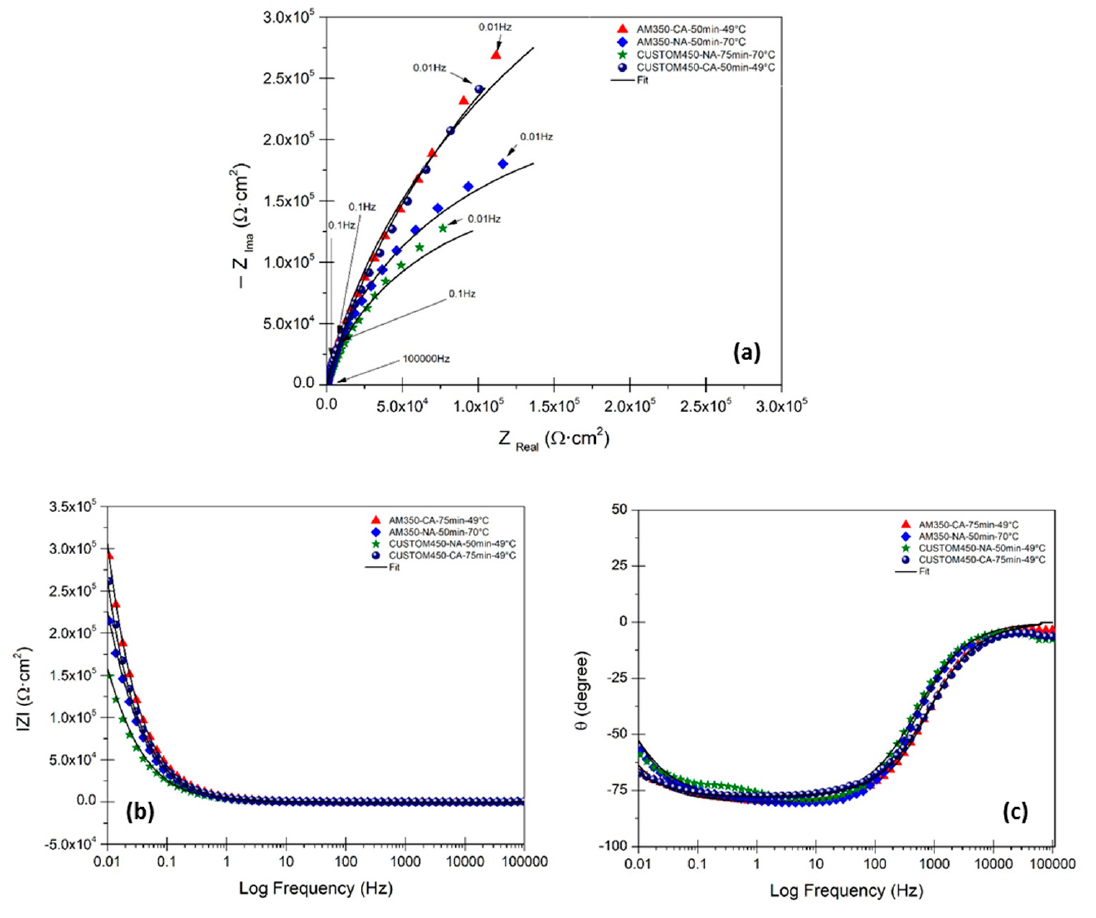
Figure 5. Nyquist ( a ) and Bode ( b , c ) plots of CUSTOM 450 and AM 350 passivated stainless steels immersed to 5 wt. % NaCl solution.